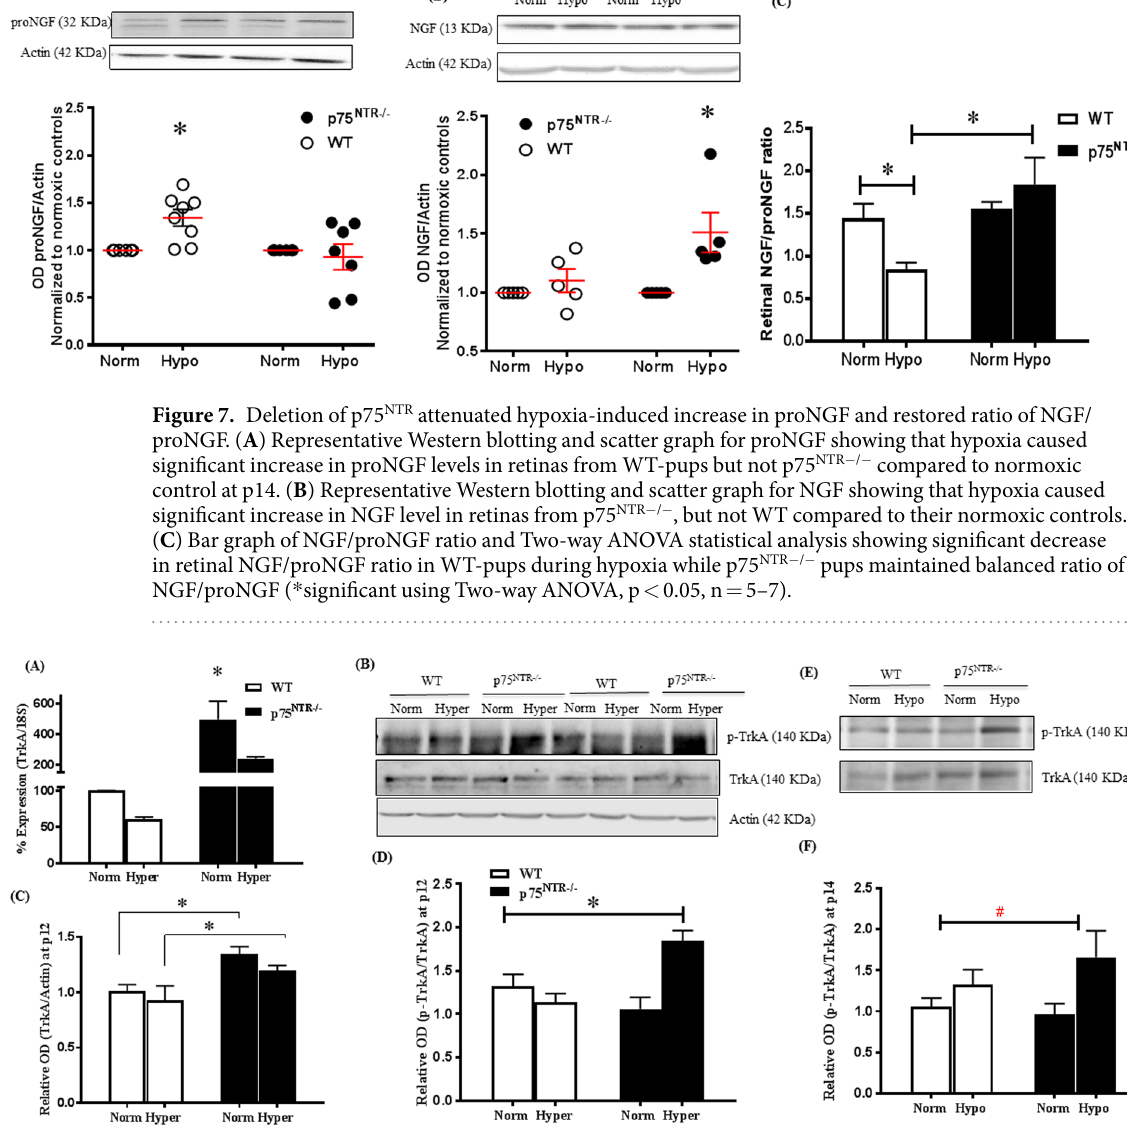
effect of hyperoxia on TrkA activation. As shown in Fig. 8B,D, retinas from p75 NTR − / − pups exposed to hyperoxia